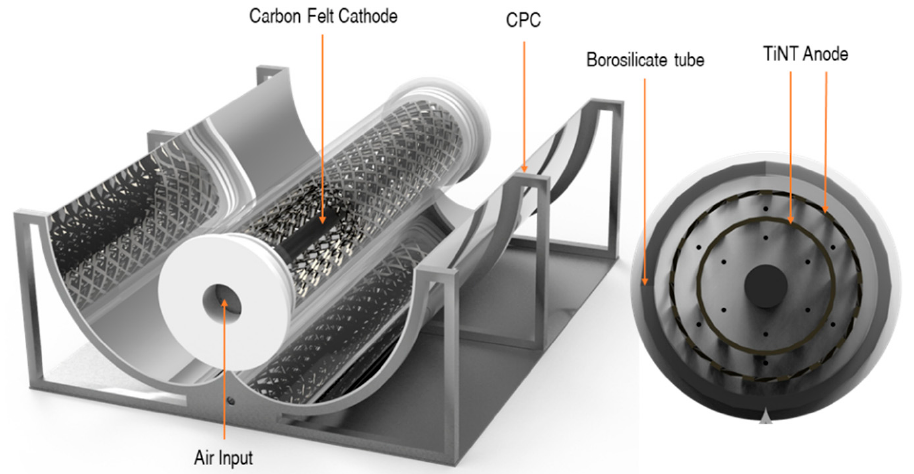
Figure 13. PEC reactor configuration with CPC. (Reproduced with permission from [67]: McMichael, S.; Waso, M.; Reyneke, B.; Khan, W.; Byrne, J.A.; Fernandez-Ibanez, P. Electrochemically assisted photocatalysis for the disinfection of rainwater under solar irradiation. Appl. Catal. B 2021 , 281 , 119485, doi:10.1016/j.apcatb.2020.119485. Copyright (2021), Elsevier Elsevier (Amsterdam, Netherlands)).